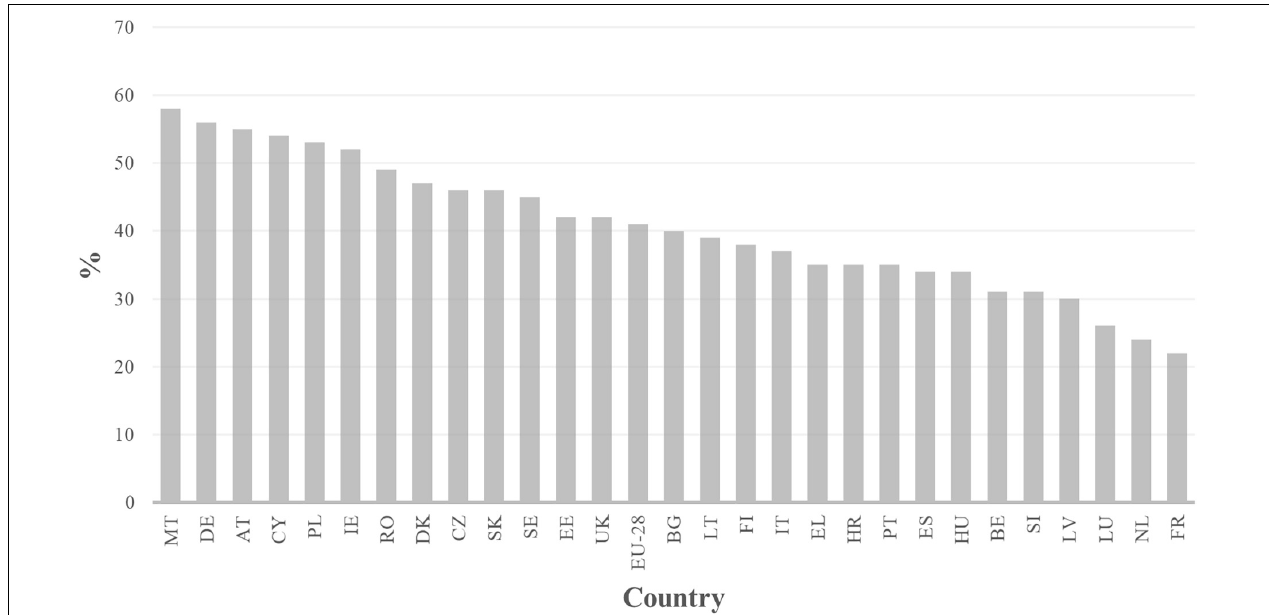
FIGURE 4 | Index of VET image in relation to the labor market (percentage of agreement). Note. Adapted from CEDEFOP (2017, p.45). This index is created with the degree of agreement with 4 items: ‘People in vocational training acquire the skills that employers in [country] need; Vocational training allows you to find a job quickly after obtaining a qualification or diploma; Vocational education leads to high-paying jobs; vocational training leads to highly valued jobs in